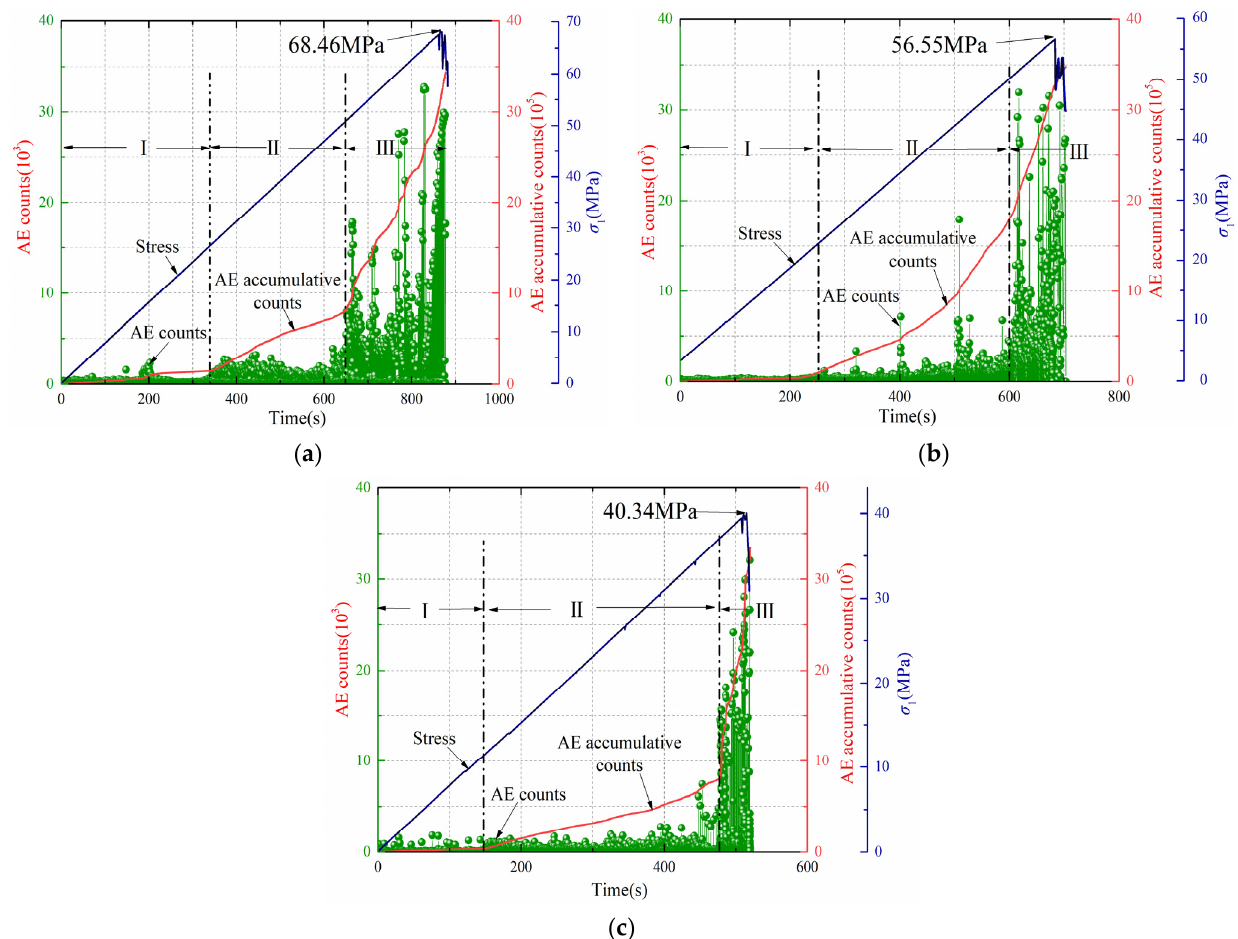
Figure 4. Acoustic emission response of the conventional triaxial test. ( a ) Samples 5. ( b ) Samples 7. ( c ) Samples 11.